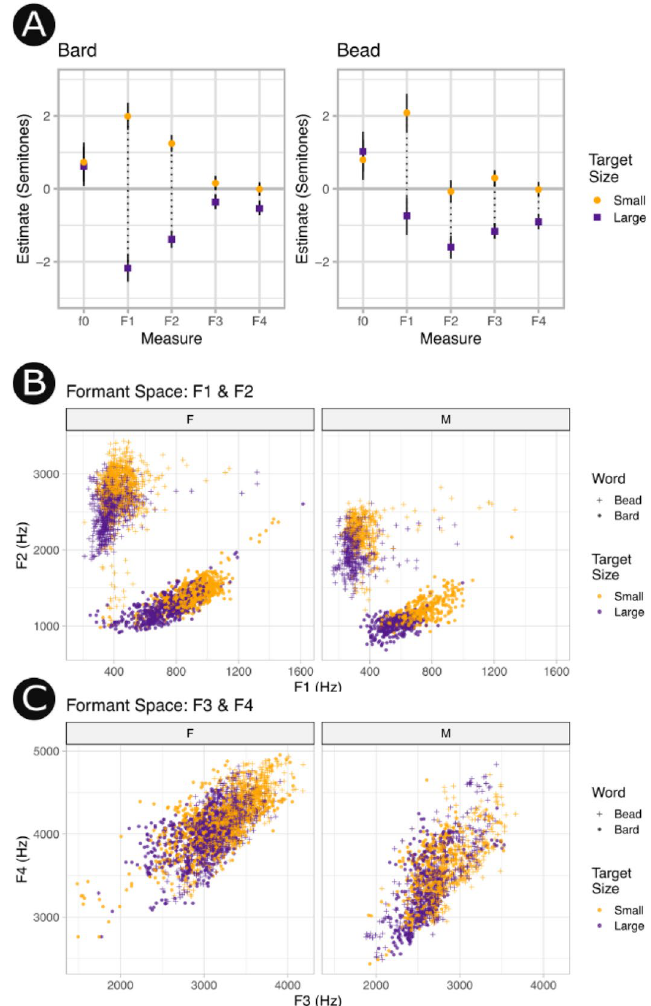
Figure 4. Exploration of acoustic measures. ( A ) Contrasts of acoustical parameters presented for the words Bard (vowel / ɑ /) and Bead (vowel /i/) while sounding large or small. Measurement pairs are joined by dotted lines to facilitate comparison. Solid lines indicate 95% confidence intervals. The two most speech- relevant acoustical measures (F1, F2) were modulated by speakers with F1 being modulated most strongly and reliably. F3 was modulated weakly and only for the carrier word Bead the vowel in which is known for the unusual property of being partly encoded by F3. ( B ) The formant space of F1 and F2 demonstrate the canonical separation of these two vowels. Strong upward frequency shifts are evident when speakers attempted to sound small (orange) and downward frequency shifts when speakers attempted to sound large (purple). ( C ) The formant space of F3 and F4 showing poor separation between attempts to sound small or large. See Supplementary Materials 1 for an interactive data visualisation of F1, F2, and f0 space demonstrating the relative independence of vocal tract modulation skill from vocal pitch